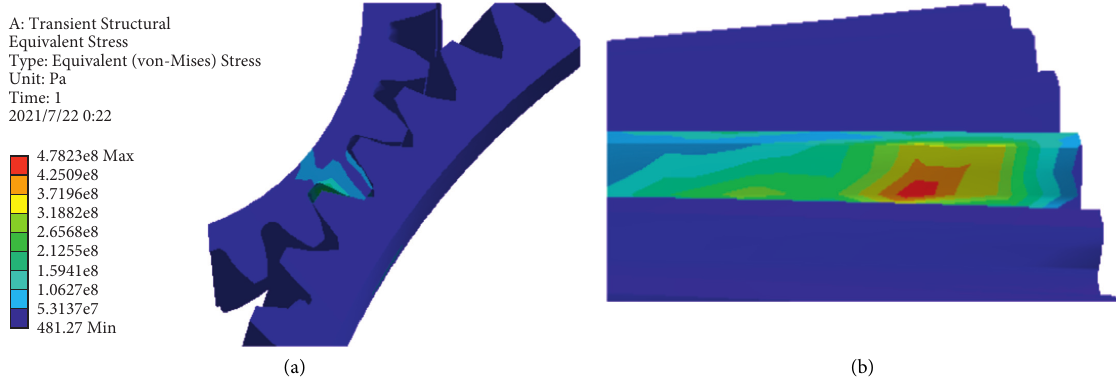
Figure 20: Equivalent stress nephogram of the helical gear group. (a) Equivalent stress nephogram. (b) Stress nephogram of helical